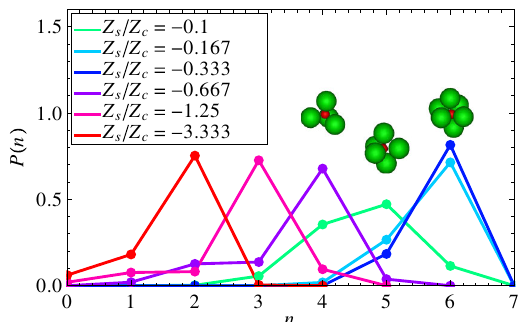
FIG. 7. Probability distribution of finding n satellite particles around a core particle, for size ratio σ s = σ c ¼ 2 . 2 = 1 , and for different values of the charge ratio Z s =Z c . Here, the Debye screening length is fixed at κσ s ¼ 1 , the core charge Z 2 λ = σ ¼ 108 . 8 , the number ratio N c B s packing fraction η ¼ 0 . 10